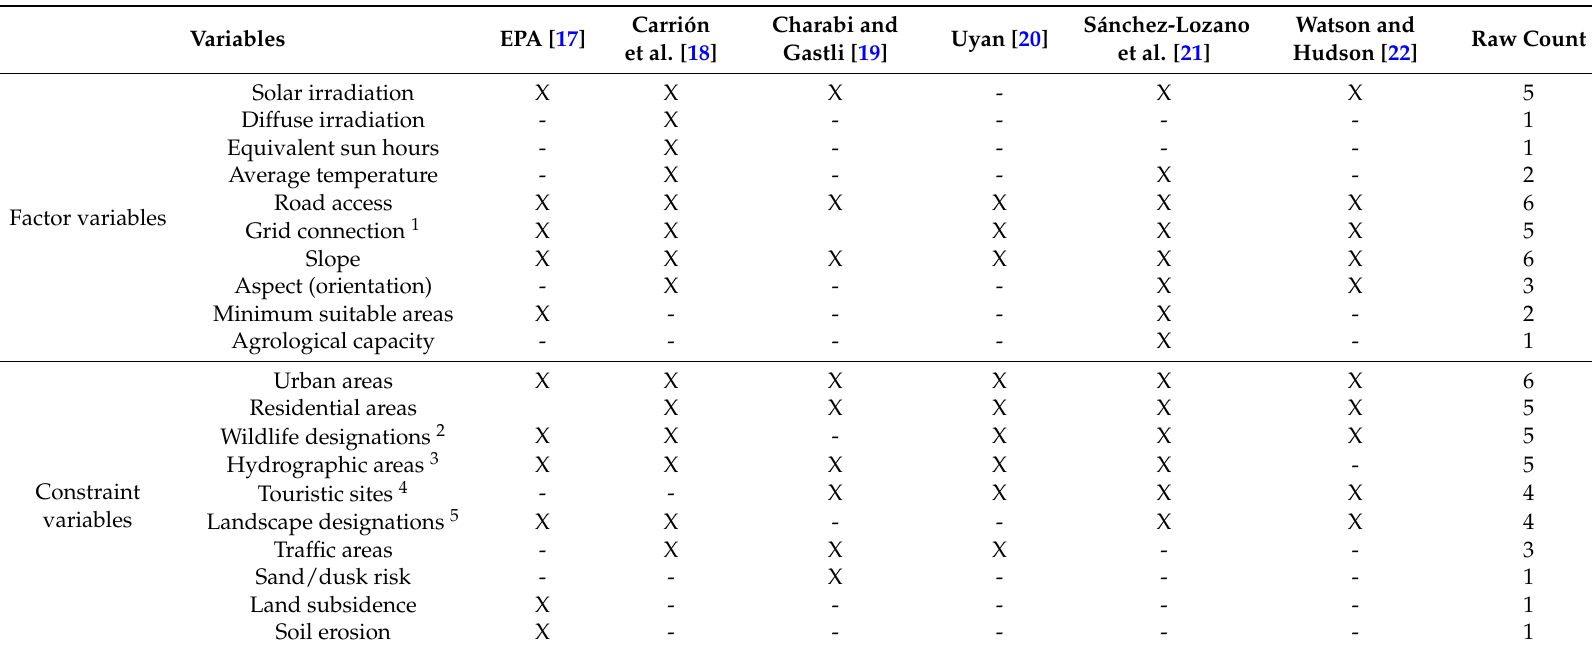
Table 1. Summary of factor variables and constraint variables used in previous geographic information system (GIS)-based solar farm site selection studies. Variables EPA [17] Solar irradiation